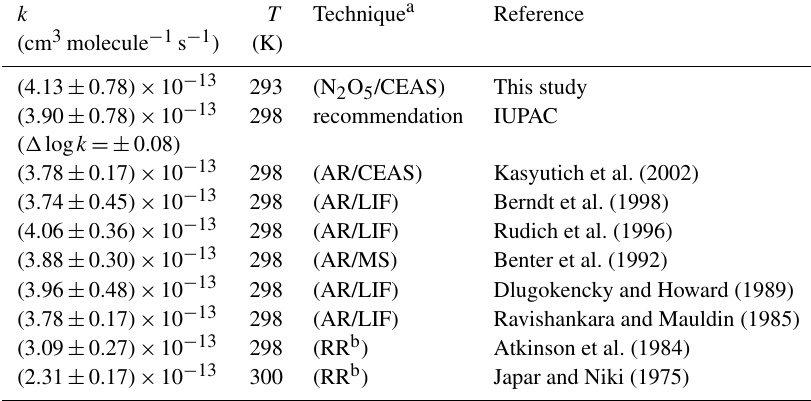
a Indicates kinetic method (AR = absolute rate, RR = relative rate) and NO LIF (laser-induced fluorescence) or MS (mass spectrometry). b Relative rate determinations are relative to the